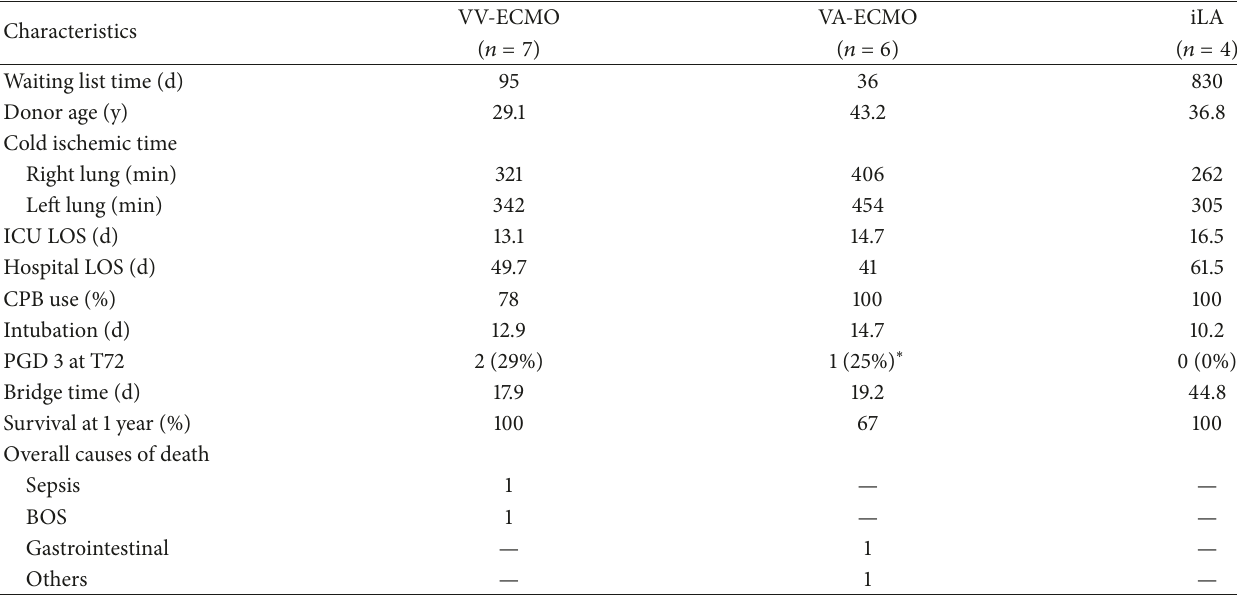
Table 2: Peri- and posttransplantation